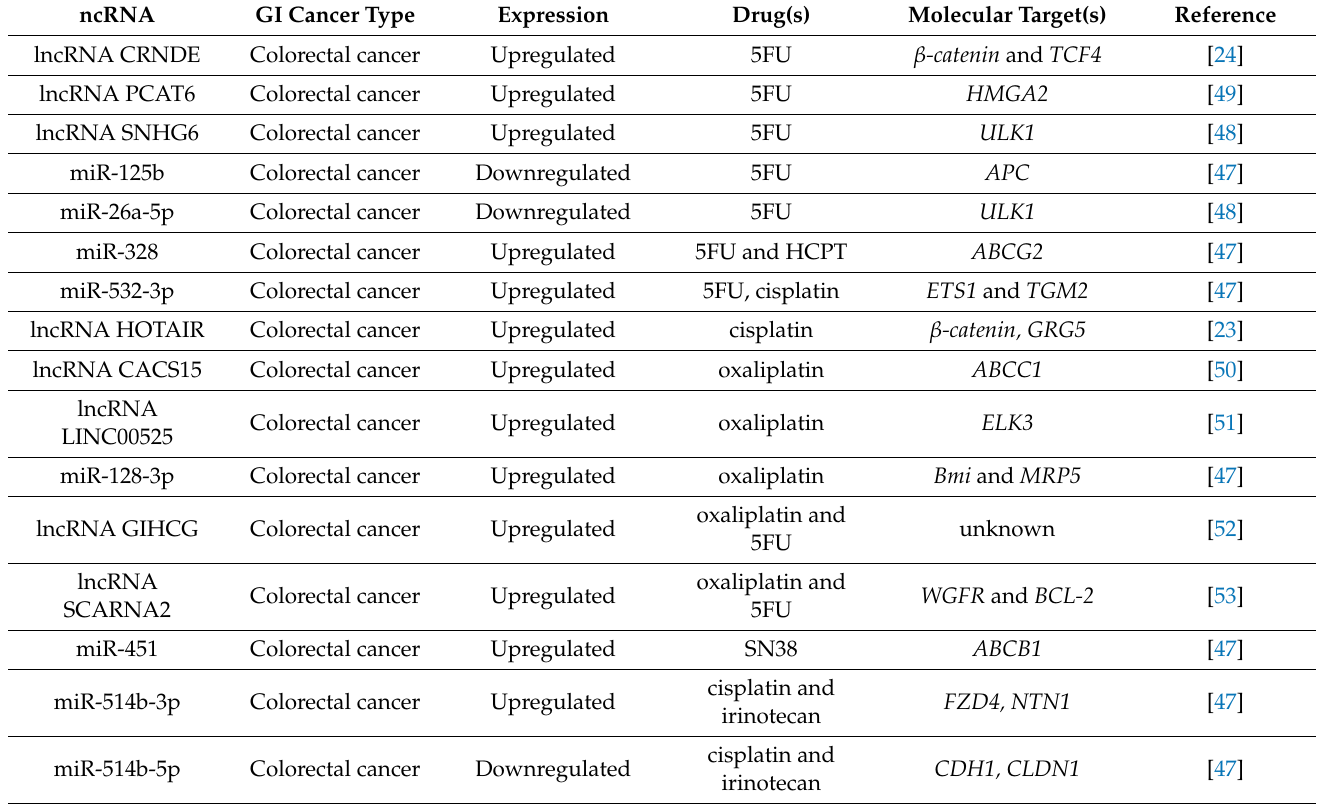
Table 1. ncRNA-mediated chemoresistance targets in GI